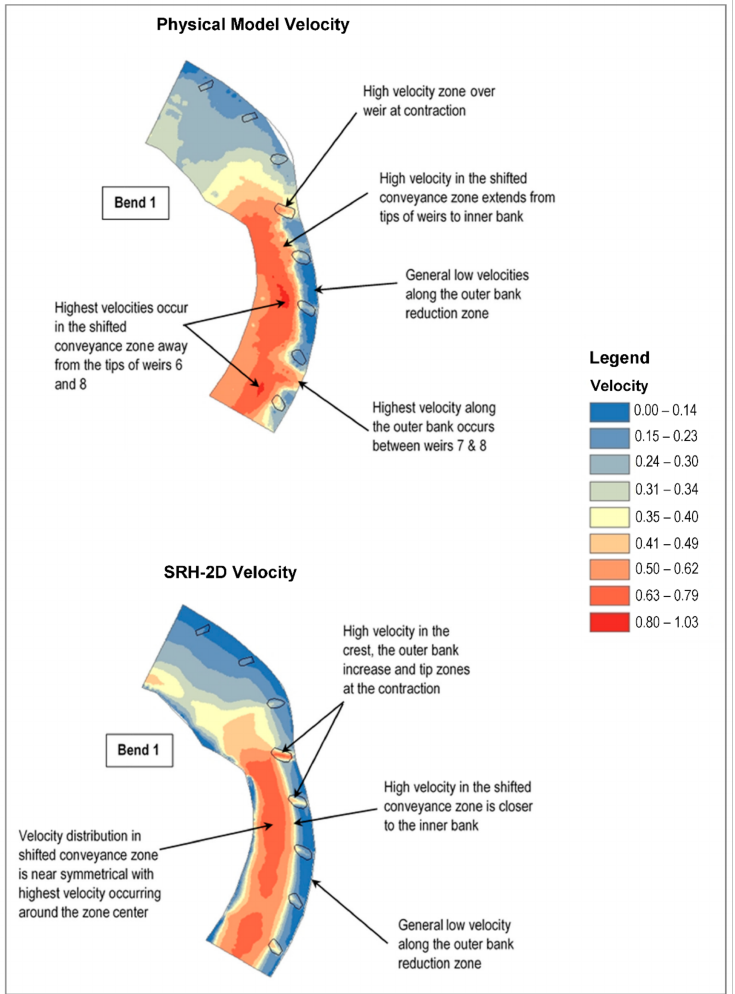
Figure 23. Bendway weir configuration BW02 comparison of physical model-measured and SRH-2D- predicted depth-averaged velocity